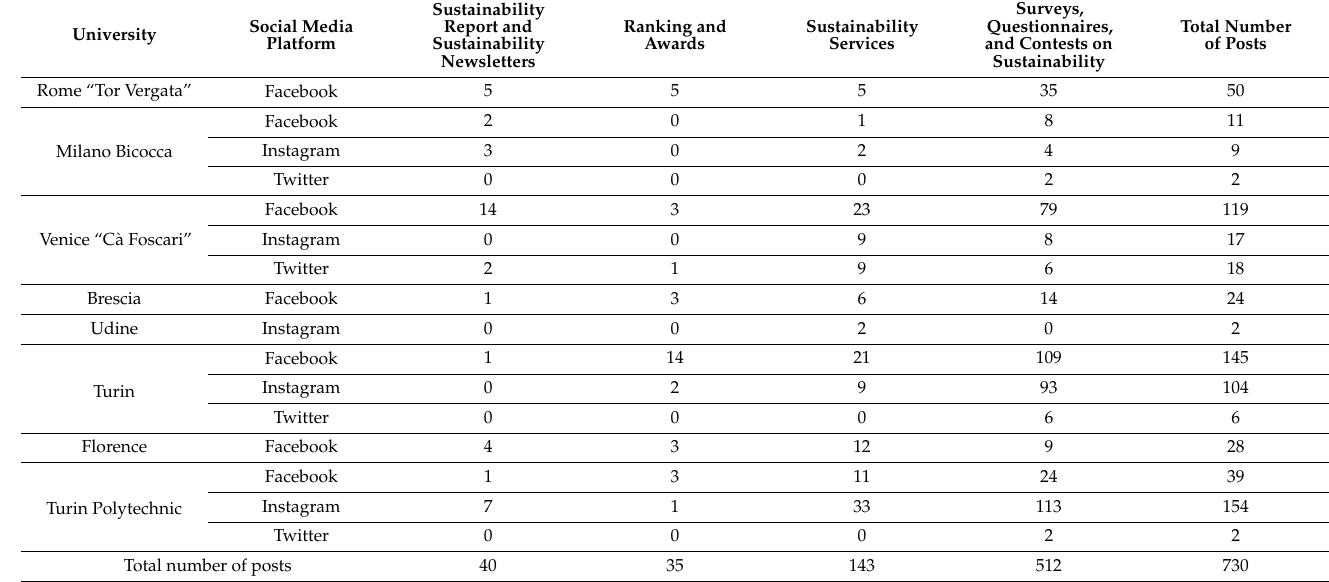
Table 2. Number of posts per topic belonging to the “social media for engaging” theme.